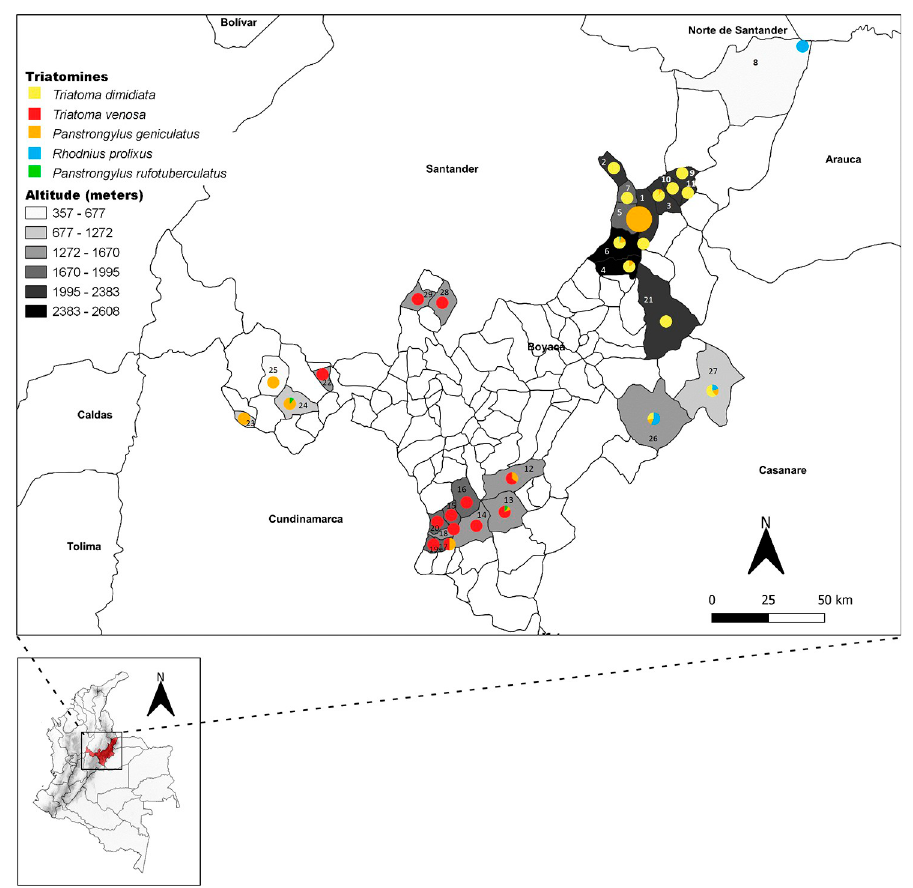
Fig 1. Distributions of triatomines collected in the 29 infested municipalities in Boyaca Department (Colombia) between 2017 and 2018. Grayscale box represent the altitudinal ranges (m.a.s.l.). Yellow circle - T. dimidiata , red circle - T. venosa , orange circle - P. geniculatus , blue circle - R. prolixus and green circle - P . rufotuberculatus . Altitude ranges are illustrated in grayscale. 1-Boavita, 2-Covarachia, 3-San Mateo, 4-Sativa Norte, 5-Soata, 6-Susacon, 7-Tipacoque, 8-Cubara, 9-El Espino, 10-Guacamayas, 11-Panqueba, 12-Zetaquira, 13-Miraflores, 14-Garagoa, 15-Pachavita, 16-Chinavita, 17-Sutatenza, 18-Tenza, 19-Guateque, 20- La Capilla, 21-Socota, 22-Brice ñ o, 23-La Victoria, 24-Maripi, 25-San Pablo de Borbur, 26-Labranza Grande, 27-Paya, 28-Chirataque, 29-San Jose de Pare. The size of circles corresponds to number of triatomines recollected. Big circles more than 100 and small circles less